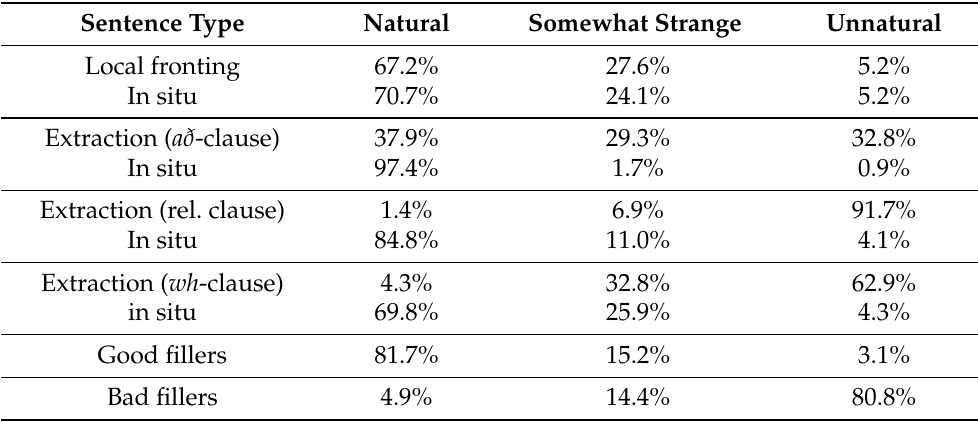
Table 3. Answers per sentence type,